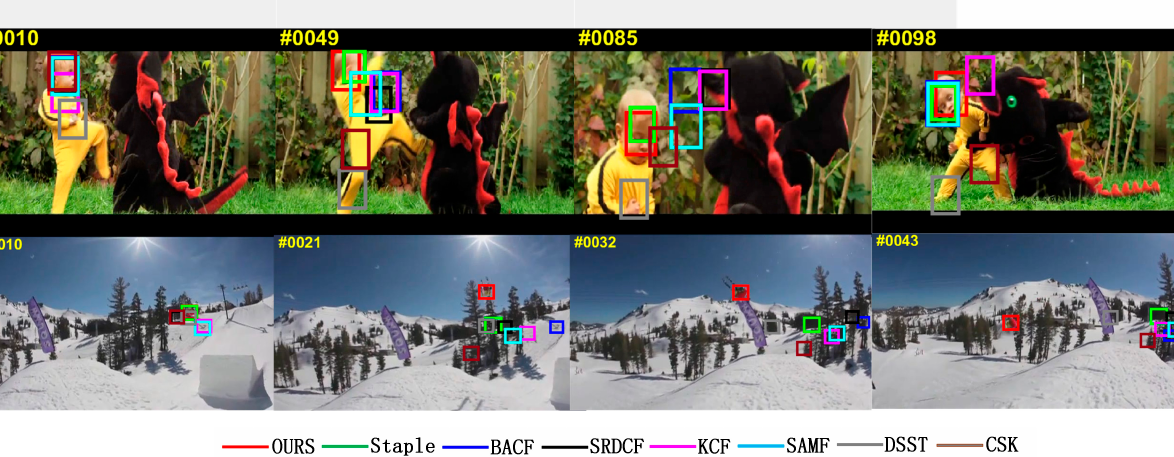
Figure 9. Visual comparison with eight trackers in the “DragonBaby_1” and “Skiing_1” video sequences in an occlusion challenge scenario.